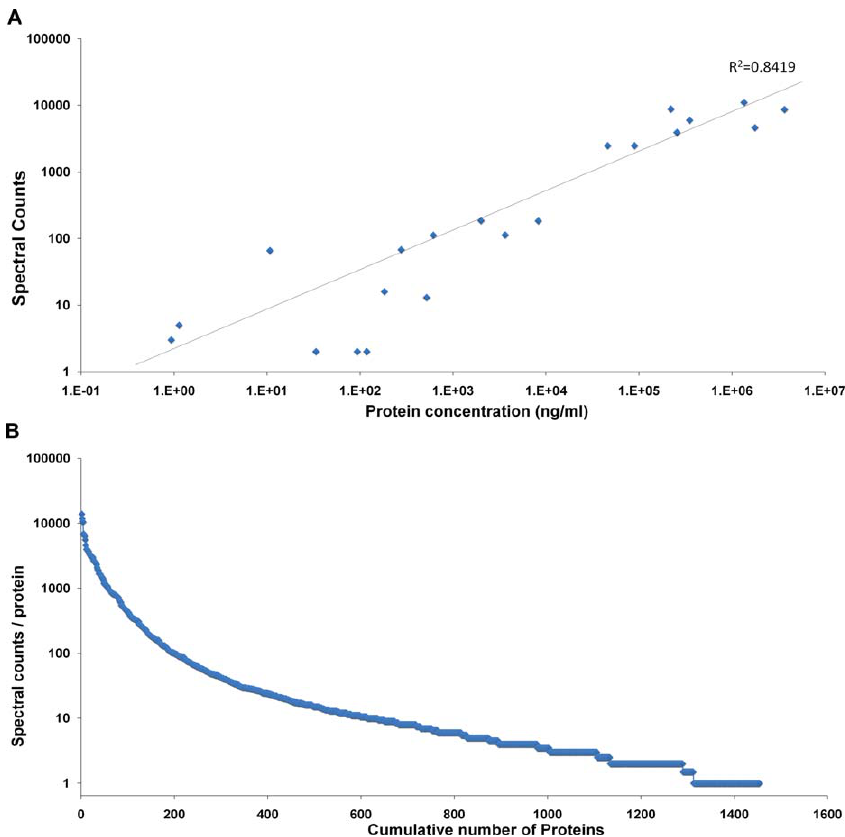
Figure 3. Identification of Low Abundance Proteins in Mouse Plasma (A) Spectral counts (number of MS2-events acquired per protein) in the experiment performed for early stage pancreatic cancer mouse plasma protein (PanIN) were correlated with protein plasma concentration reported by Rules-Based Medicine (http://www.rulesbasedmedicine.com/case3/Table3.htm). The 21 proteins used for this estimation were: Serpina1b, Adipoq, A2m, Apoa1, Apoc3, Apoh, B2m, C3, Ceacam1, Crp, Fabp1, F7, Ftl1, Fgb, Hp, Icam1, Igf1, Mb, Serbp1, Timp1, Vcam1. As an approximation, we estimated the protein concentration with the correlation (log spectral counts ¼ [0.623 3 log protein concentration] þ 0.0625). (B) Taking into consideration the correlation of spectral counts and protein concentration, we observed an inverse relationship between the total number of proteins identified and their abundance (number of